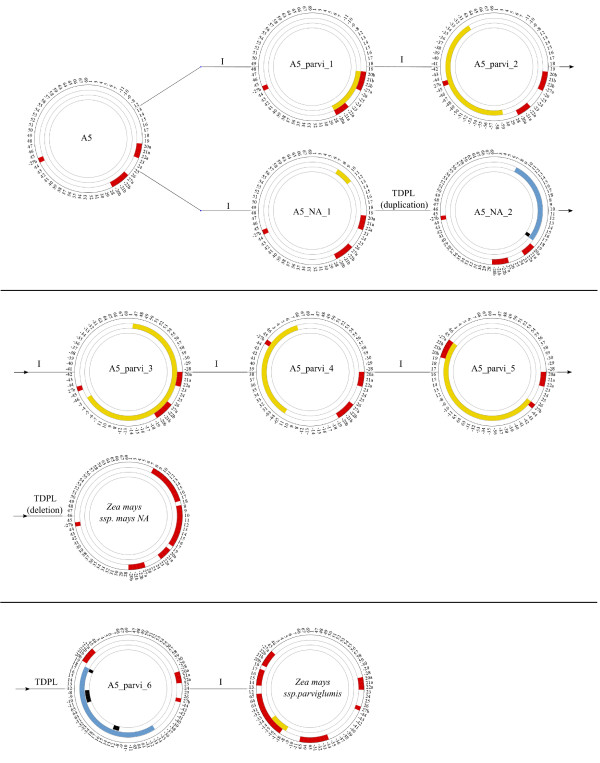
Predicted evolution from A5 to NA and Zea mays ssp. Parviglumis. Example of an evolutionary scenario from A5 to Zea mays ssp. mays NA and Zea mays ssp. parviglumis. A5 (the ancestral sequence computed by MGR) and intermediate mitogenomes after each rearrangement event are shown. Evolution of A5 mitogenome through inversions, tandem duplications (respectively yellow and blue in the middle circle) and synteny anchor loss (black in the internal circle) leads to NA (with 2 rearrangements) and Zea mays ssp. parviglumis (with 7 rearrangements). Duplicated synteny anchors are in red (outside circle). On each branch, the rearrangement event is indicated (I = Inversion, TDPL = Tandem Duplication with Partial Loss). For NA, the TDPL is indicated in two steps: a duplicated event followed by a deletion event.